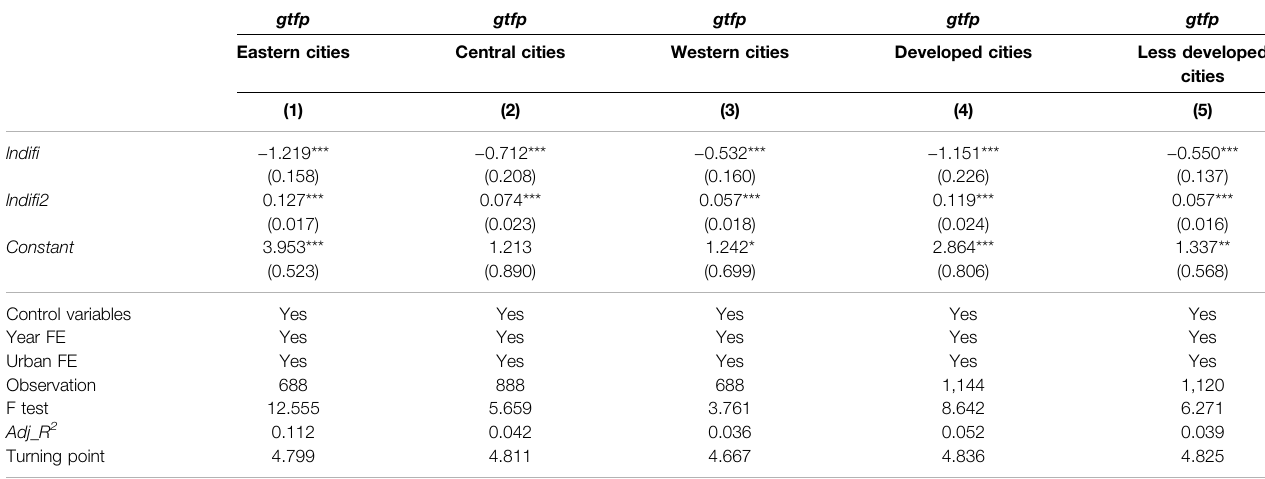
TABLE 11 | Heterogeneity test results.